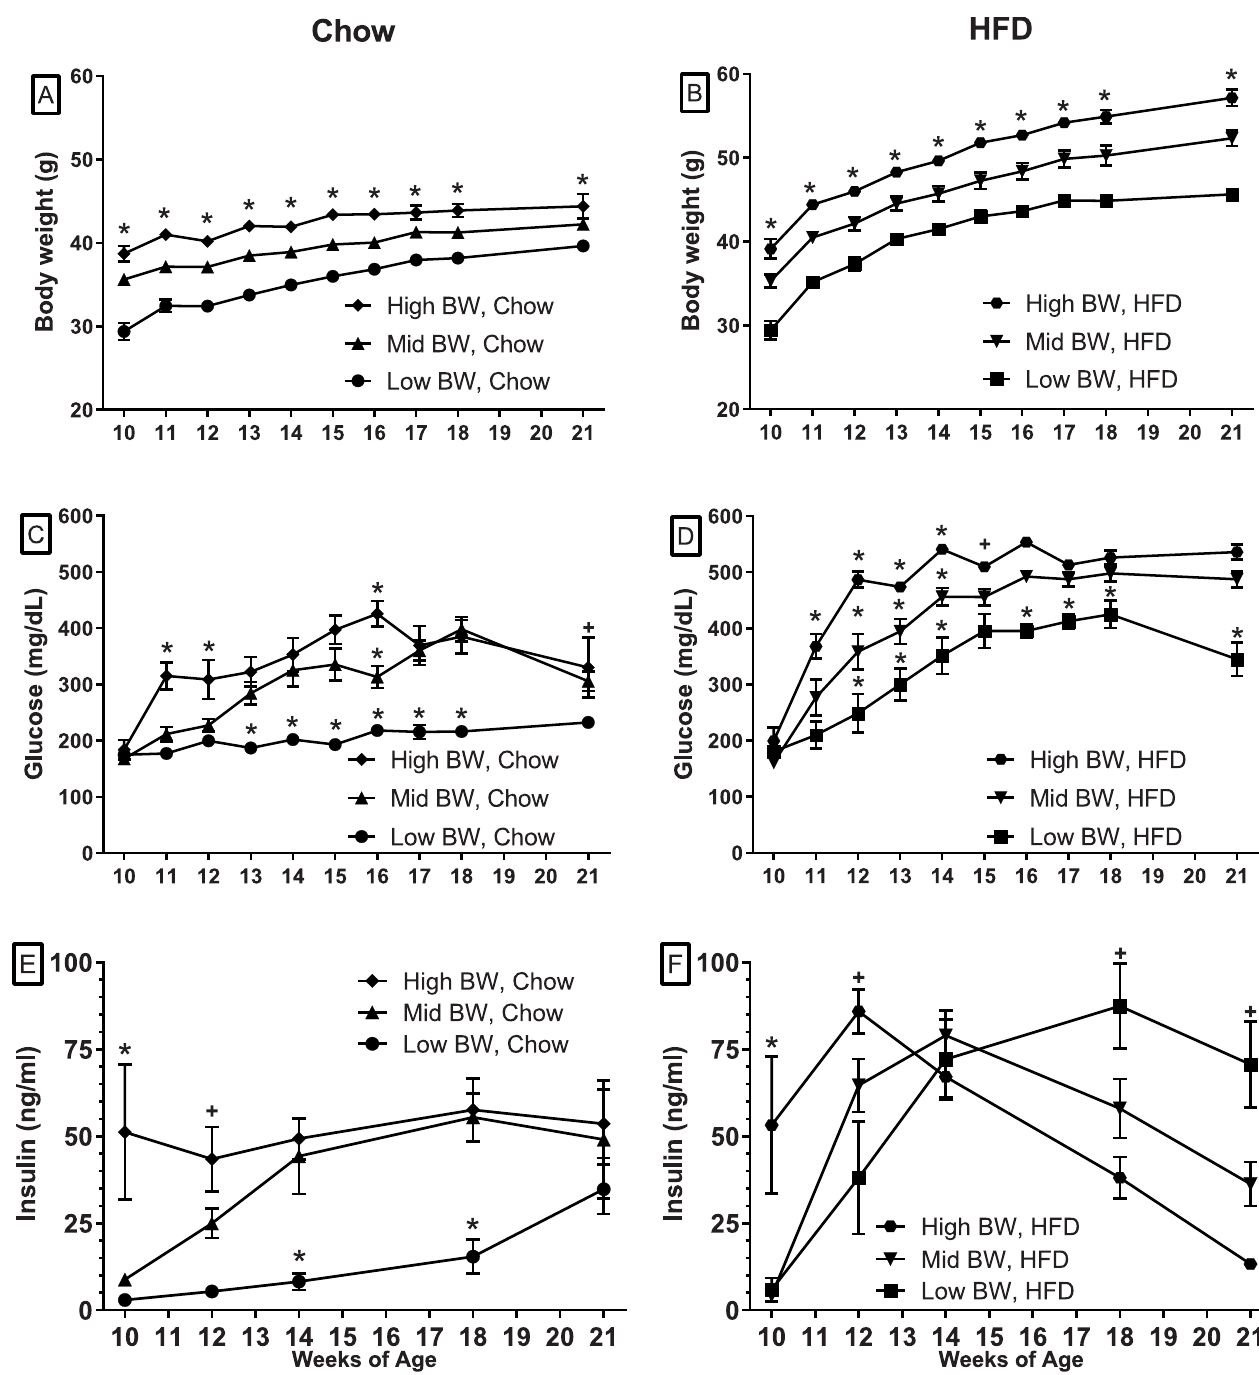
Fig 1. The effects of initial weight and diet on body weight, glucose and insulin levels. The top figures illustrate Body weight gains of animals on the Chow diet (A) and HFD (B). The middle panels(C, D) demonstrate the effects of the two diets on glucoselevels. Insulin levels in Chow (E) and HFD (F) groups are illustratedin bottom panels.The * (A, B) indicates that all weight groupsare statistically different from each other at all of the time-points with each diet. Statistical differencesfrom the other groups(C-F) are identifiedby * while the + sign identifies differences between the highestand lowest values (two-way ANOVA followedby Sidak’s multiplecomparisontest, * or + p < .05). Additional differences betweendiets in each weight category are summarized in the text.